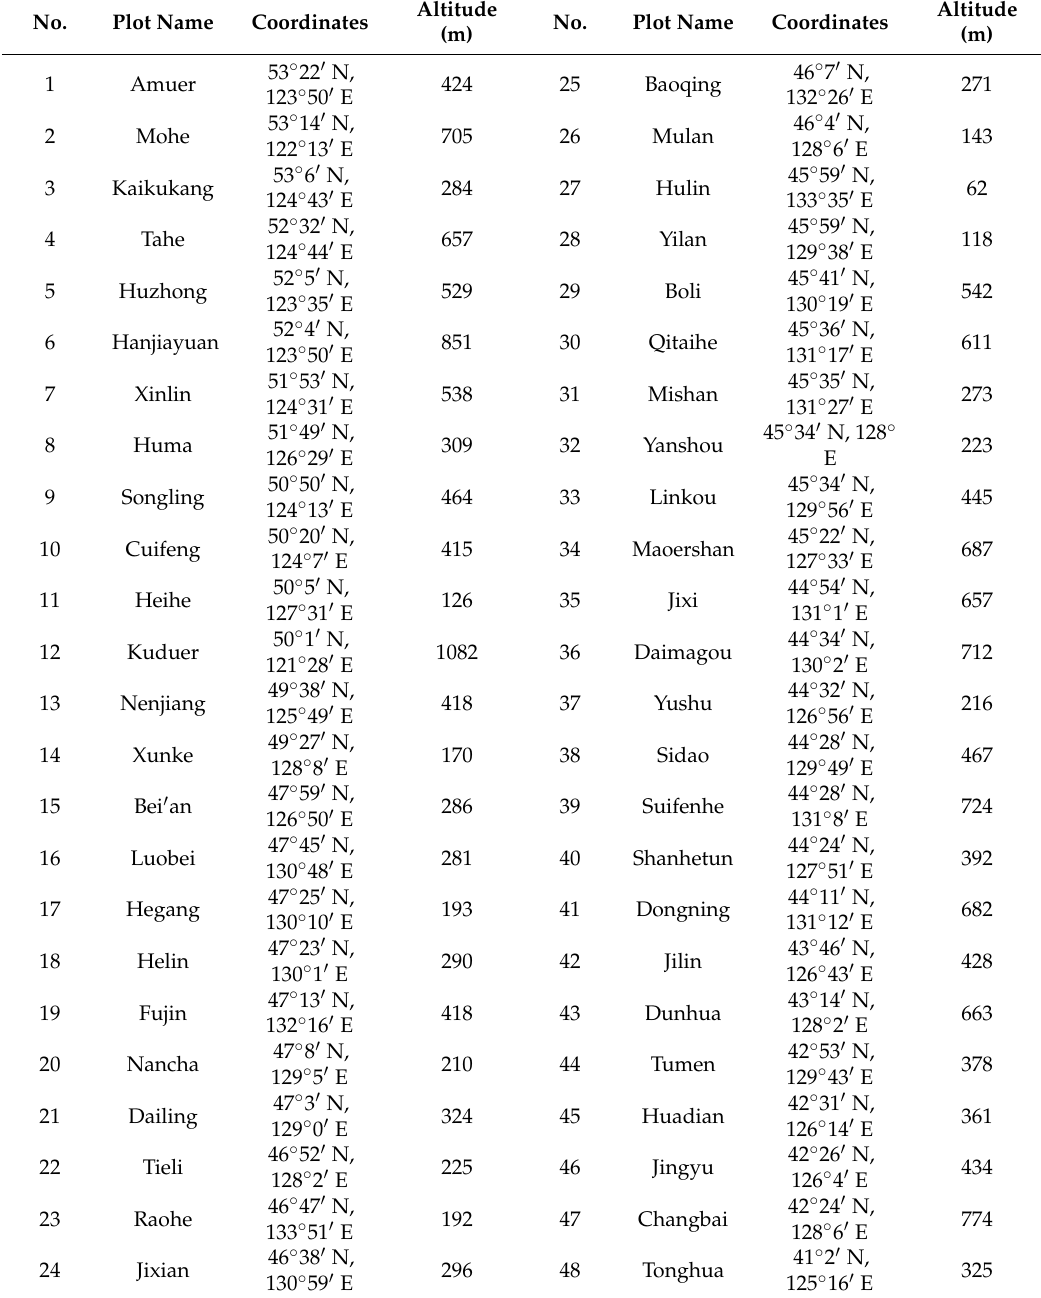
Table 1. Geographical distribution of 48 sampling plots of birch trees for triterpenoid extracts in Xing’an Mountains and Changbai Mountains, Northeast of